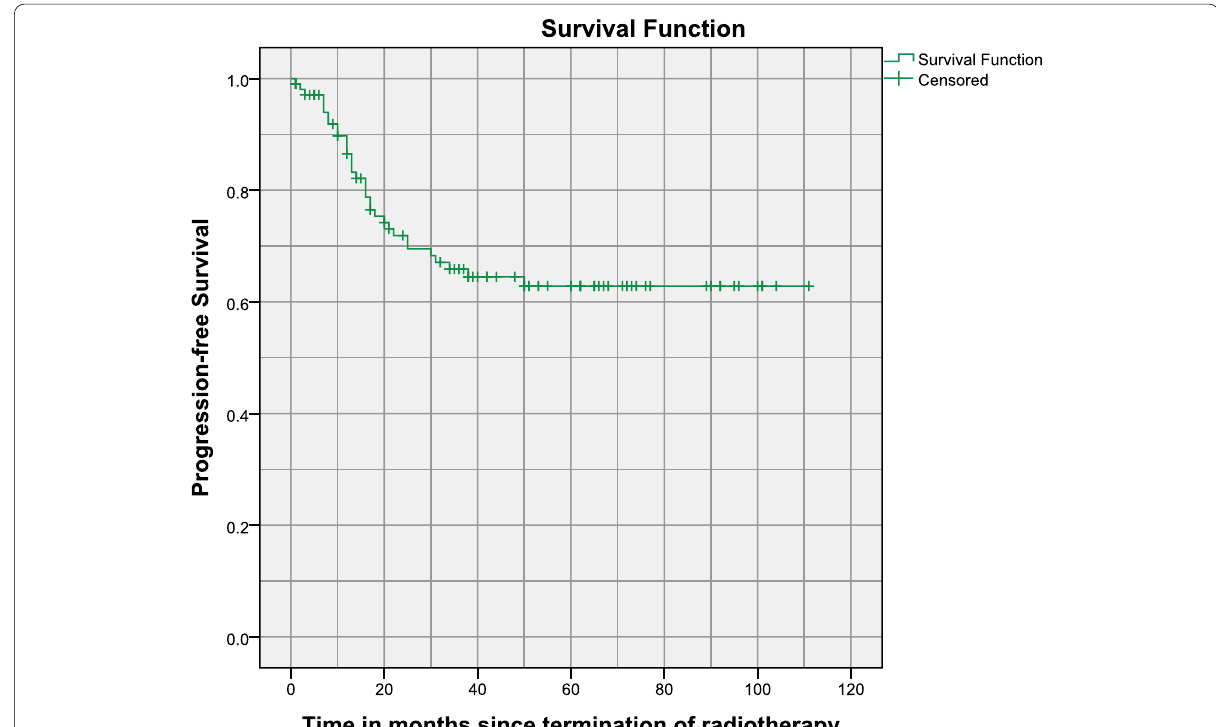
Fig. 2 Kaplan-Meyer survival curve for progression free survival